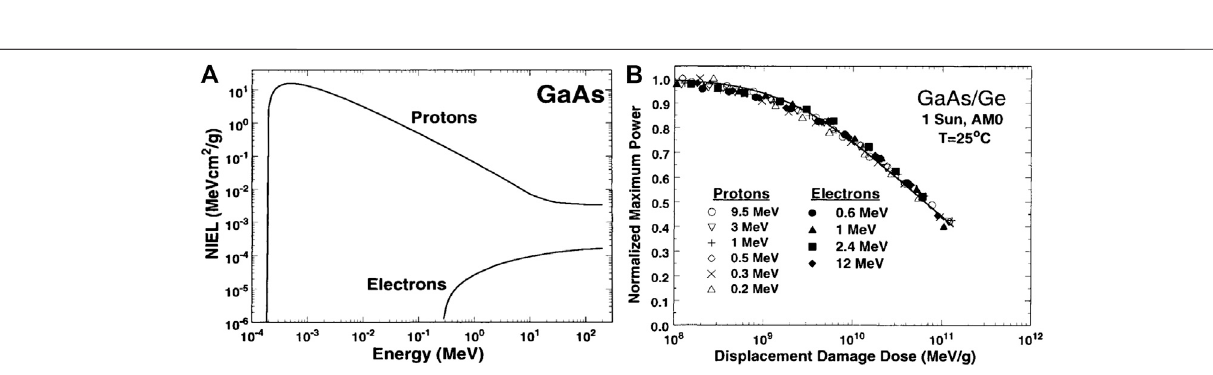
FIGURE 9 | (A) NIEL of electron and proton irradiation in GaAs; (B) using the electron to proton damage equivalency factor Rep to fi t all of the data from Figure 4 come a single curve [88].